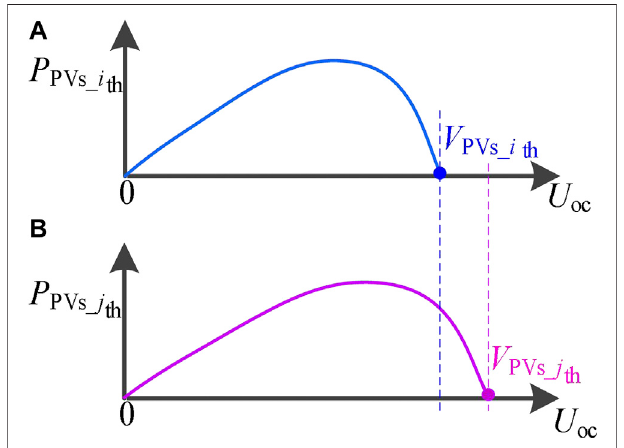
FIGURE 7 | PV power generation curves in the independent connection type: (A) . The power generation curve of the i th PV string; (B) The power generation curve of the j th PV string.